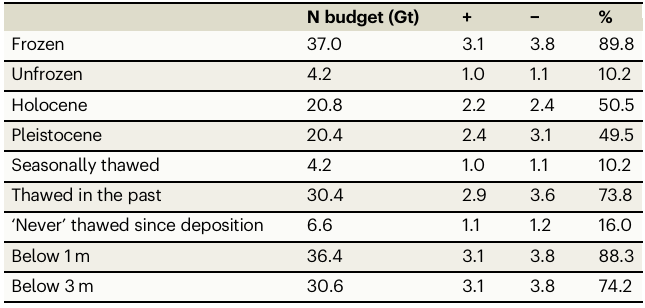
Table 2 | Classi fi cation of the N pool according to age, depth and thaw legacy